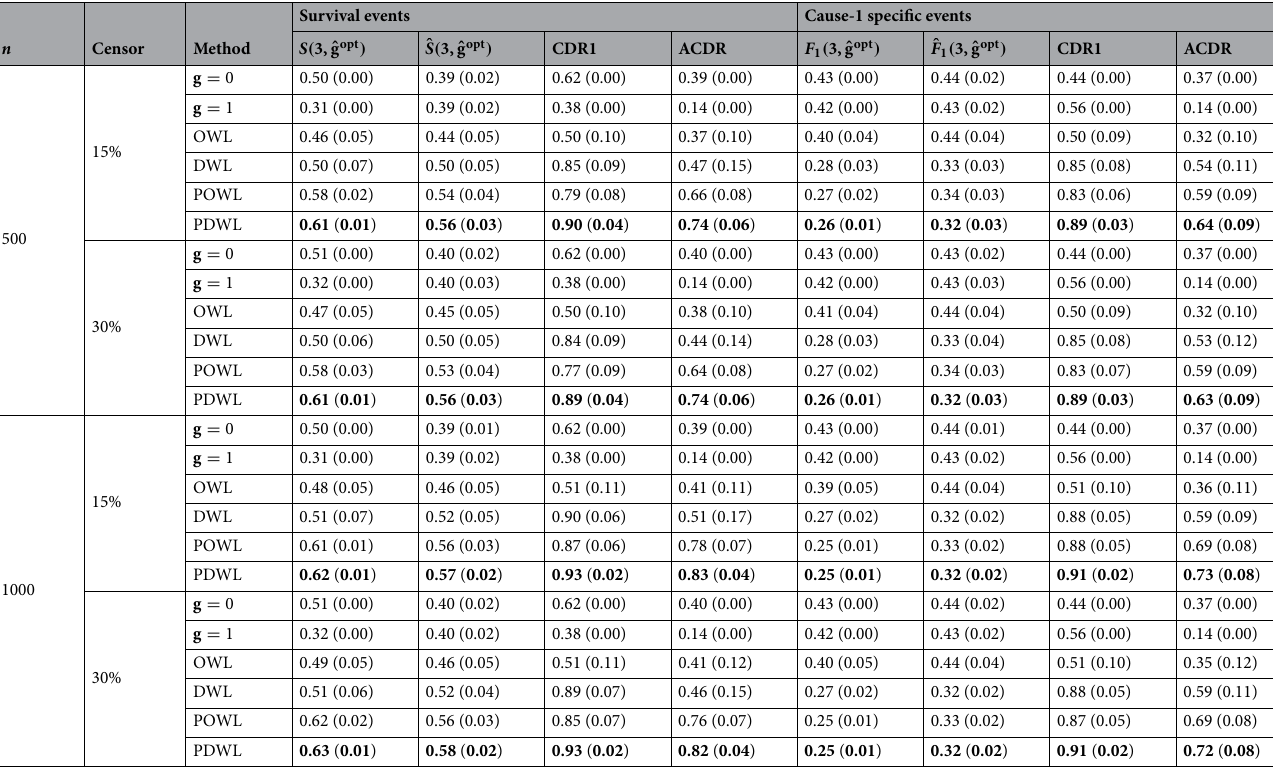
Table 1. Performance of several DTR algorithms. The table reports optimized t -year survival and t -year cumulative incidence rates, correct decision rate at first stage (CDR1), and average correct decision rate of two stages (ACDR). For each scenario, the best model is highlighted in